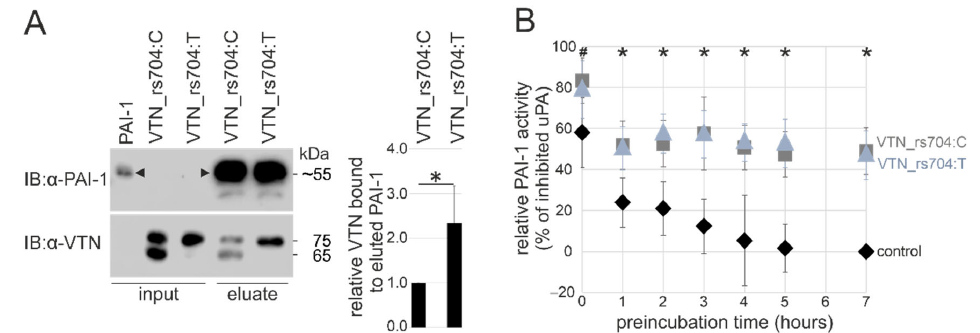
Figure 2. Effect of rs704 on vitronectin capacity to bind PAI ‐ 1 and maintain its active state. ( A ) Af